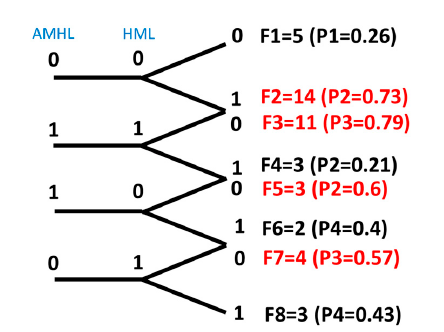
J. Risk Financial Manag. 2019 , 12 , x FOR PEER REVIEW Figure A11. Use CMA to forecast the direction of CMA. Figure A11. Use CMA to forecast the direction of CMA. Figure A11. Use CMA to forecast the direction of CMA.